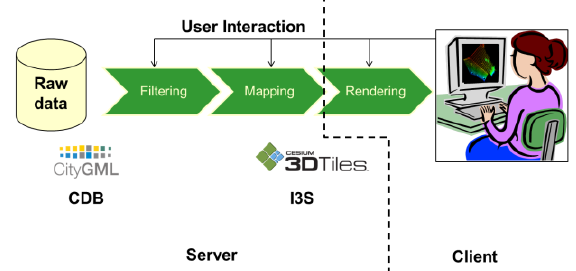
Figure 2. Distributed Visualization Pipeline and the role of OGC standards used in this